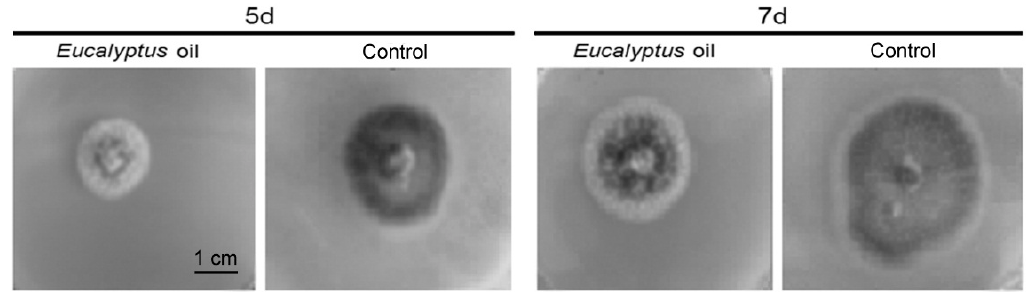
Figure 1. The oil impact on the growth of M. grisea after being cultured for 5 days and 7 days.